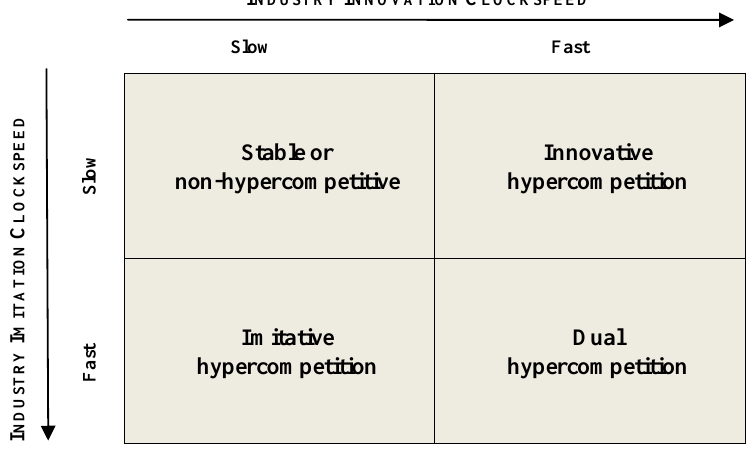
Stable or non-hypercompetitive